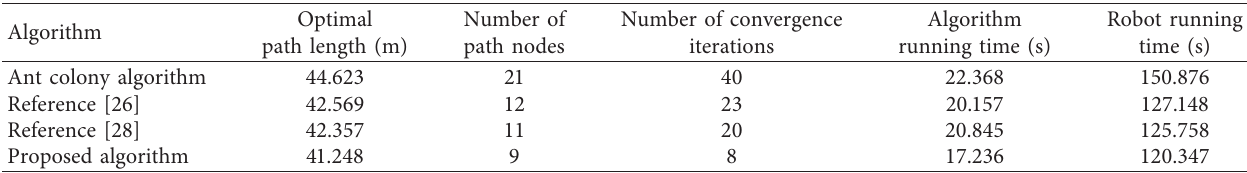
Table 2: Comparison of 30m × 30m environmental experiment